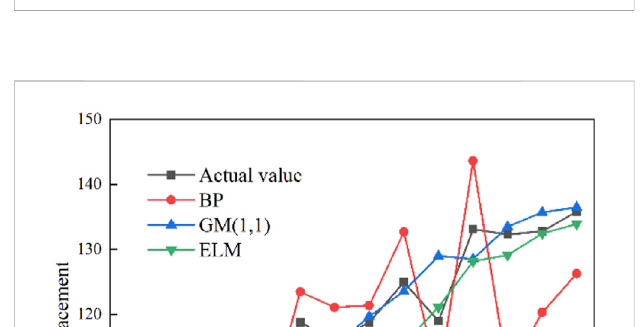
FIGURE 5 Comparison of prediction results of four